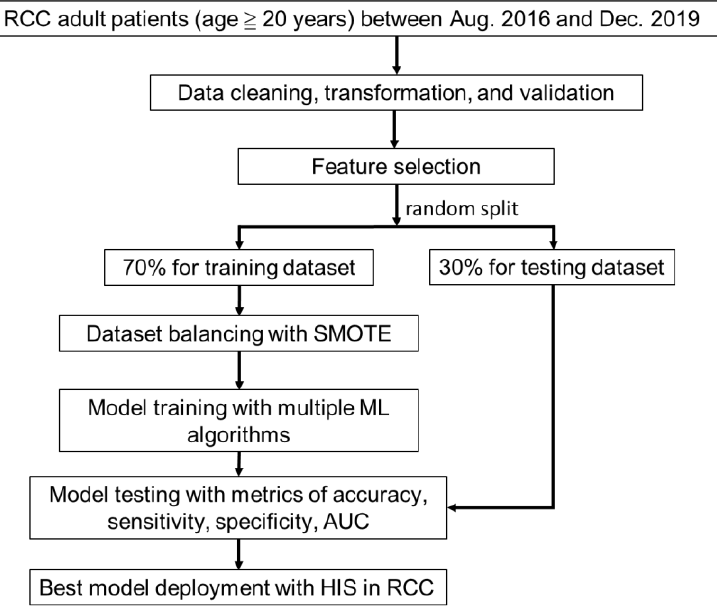
Figure 1. Research Flow. RCC: respiratory care center; SMOTE: synthetic minority oversampling tech- nique; AUC: area under the receiver operating characteristic curve; HIS: hospital information